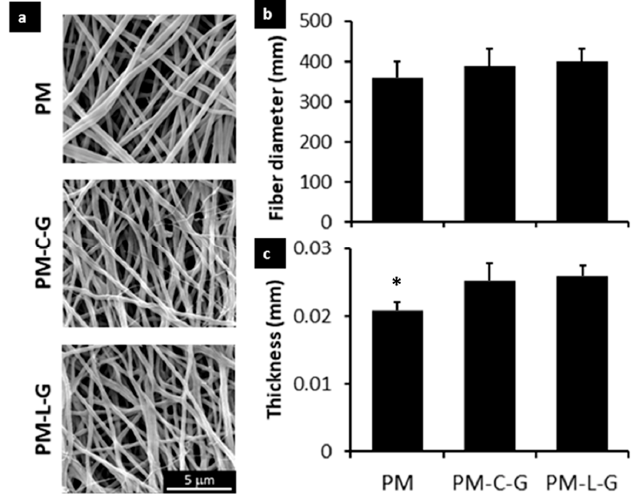
Figure 2. Scanning electron micrographs of ( a ) PM, PM-C-G, and PM-L-G. Bar graphs illustrate the